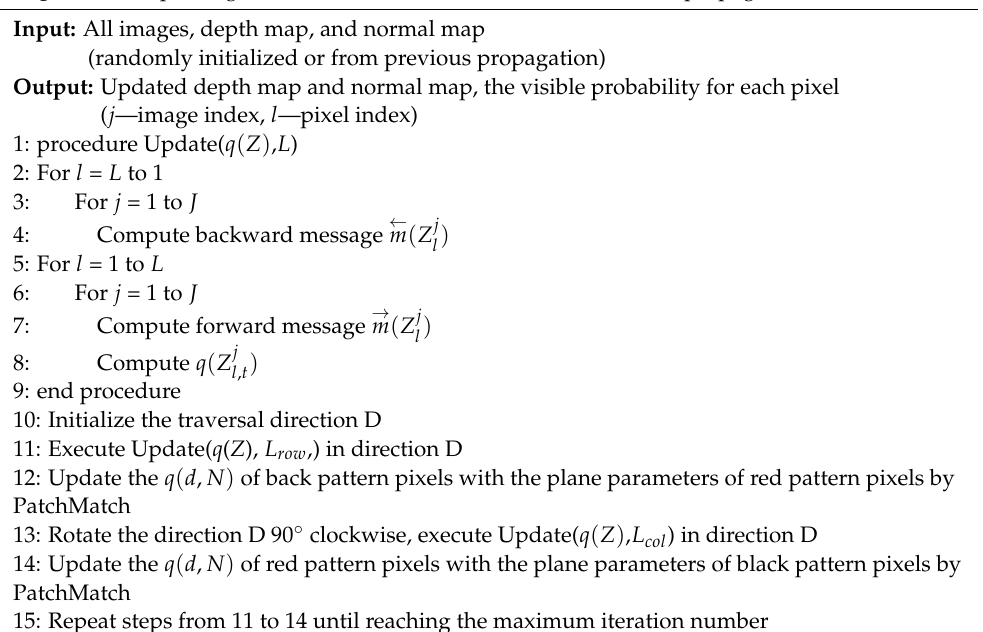
Algorithm 2 Updating schedule of random red-black checkerboard propagation